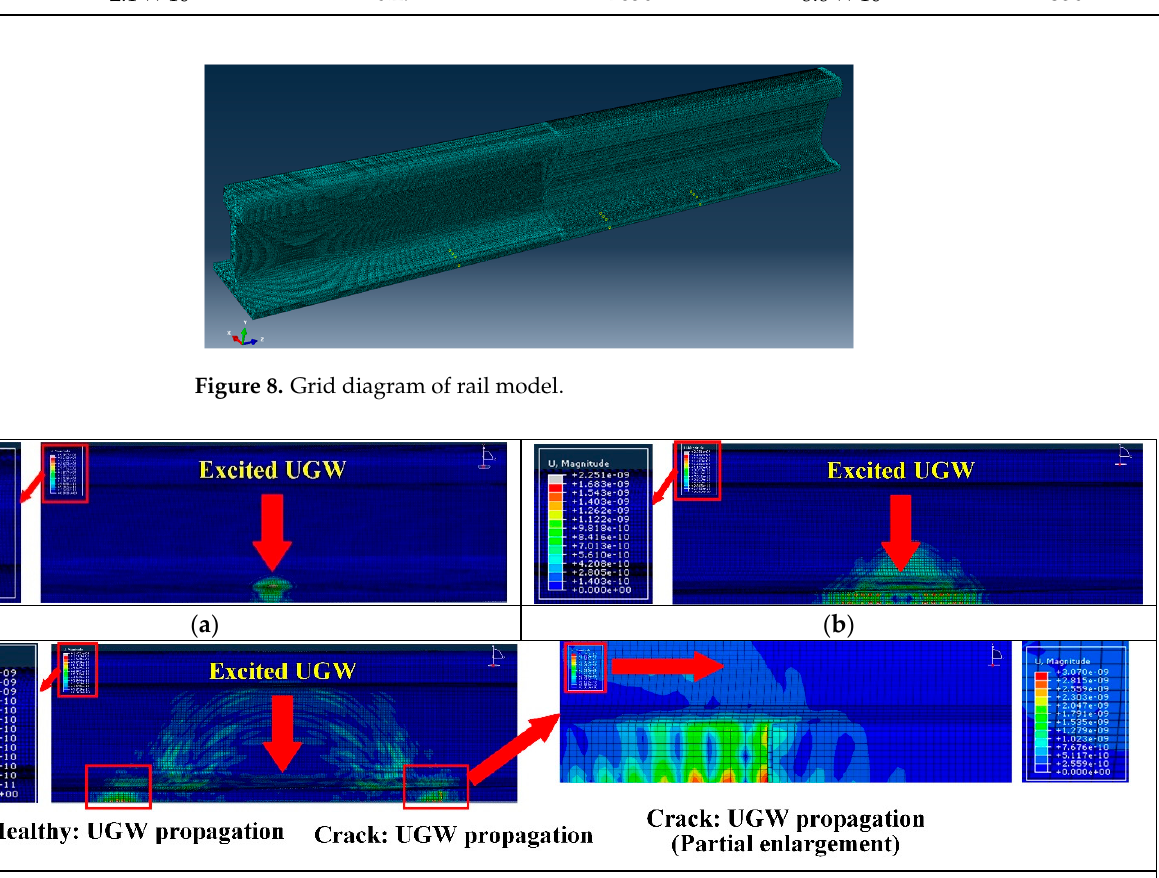
Figure 9. Propagation cloud diagram of UGW on rail bottom at different times; ( a – c ) are the propaga- tion nephograms of ultrasonic guided waves at 15 µ s, 39 µ s, and 81 µ s, respectively.